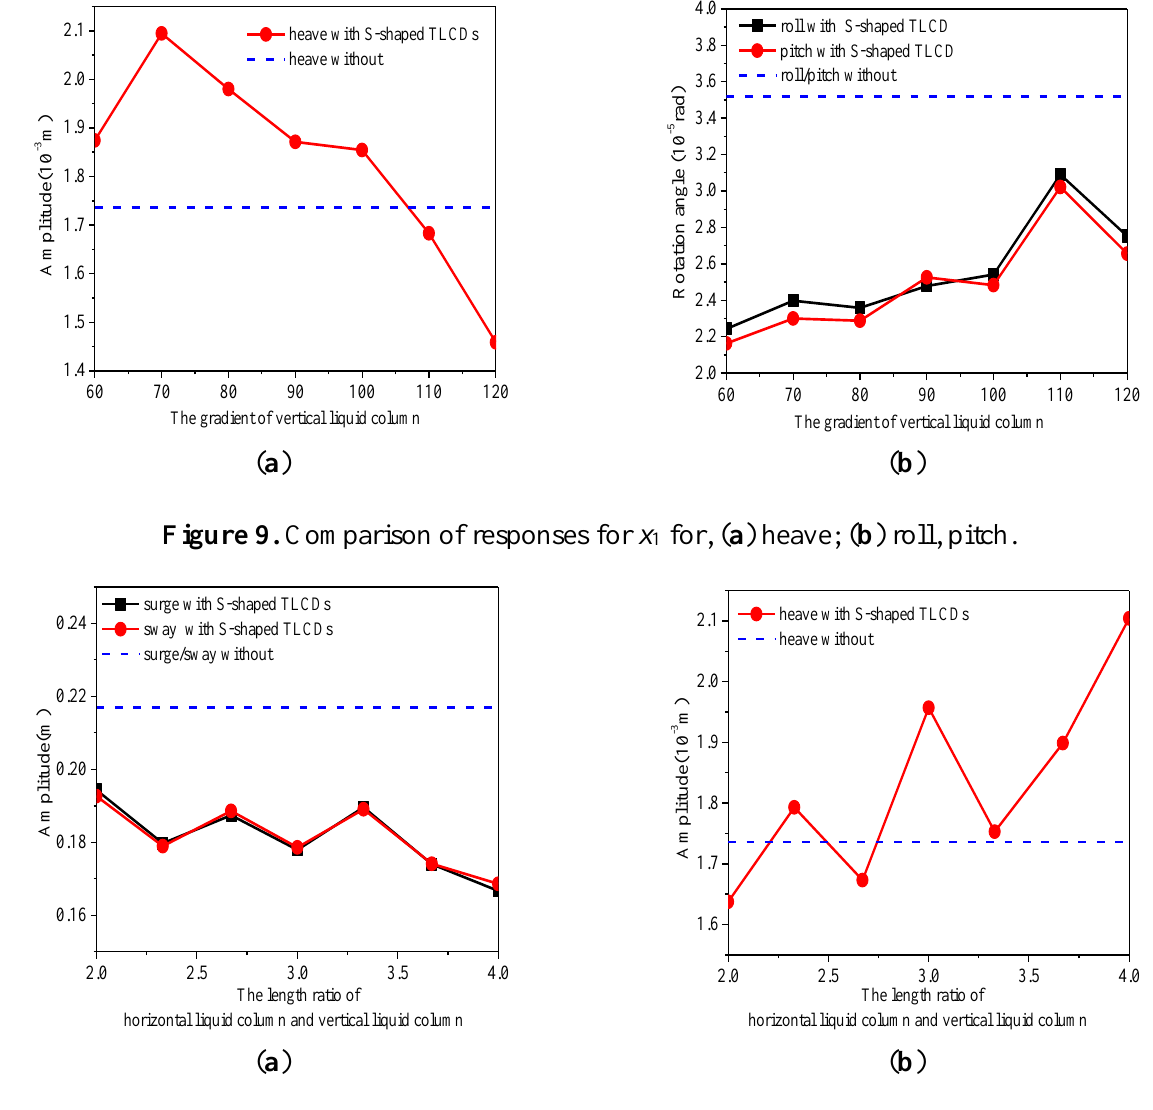
Figure 10. Comparison of responses for x 2 for ( a ) surge, sway; ( b )